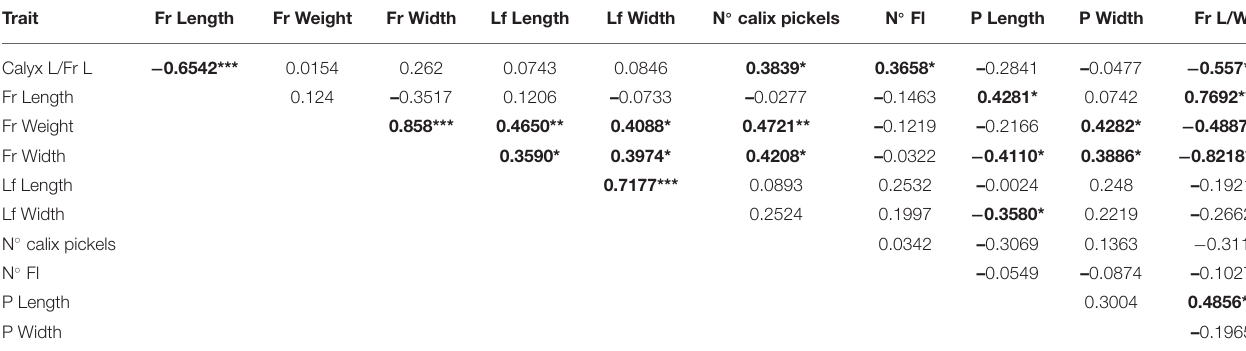
TABLE 5 | Linear correlation coefficient (r) and its significance between the quantitative traits used for phenotyping in the collection of the 31 eggplant landraces cultivated in Spain.